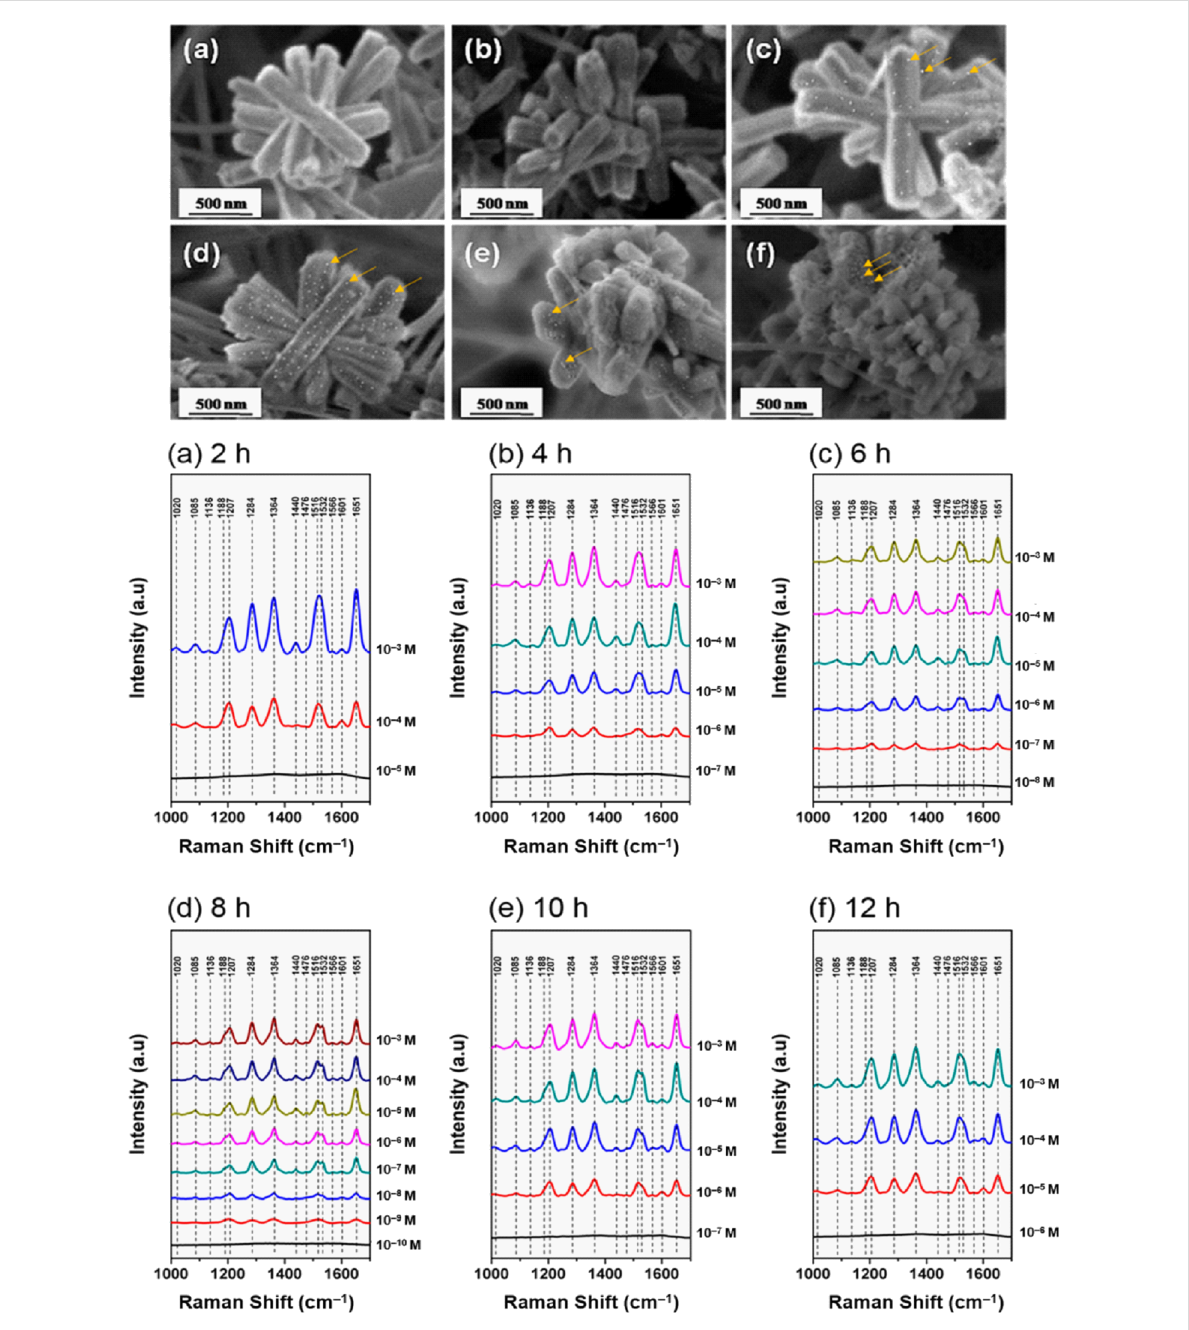
Figure 3: SEM images of silver nanoparticle–ZnO–polydopamine substrates and the SERS spectra of different rhodamine B concentrations acquired from each substrate. The deposition time of silver nanoparticles was varied for each substrate: (a) 2 h, (b) 4 h, (c) 6 h, (d) 8 h, (e) 10 h, and (f) 12 h. Figure 3 was adapted from [53] (© 2021 Chin, H.-K. et al., published by MDPI, distributed under the terms of the Creative Commons Attribution 4.0 International License, https://creativecommons.org/licenses/by/4.0).